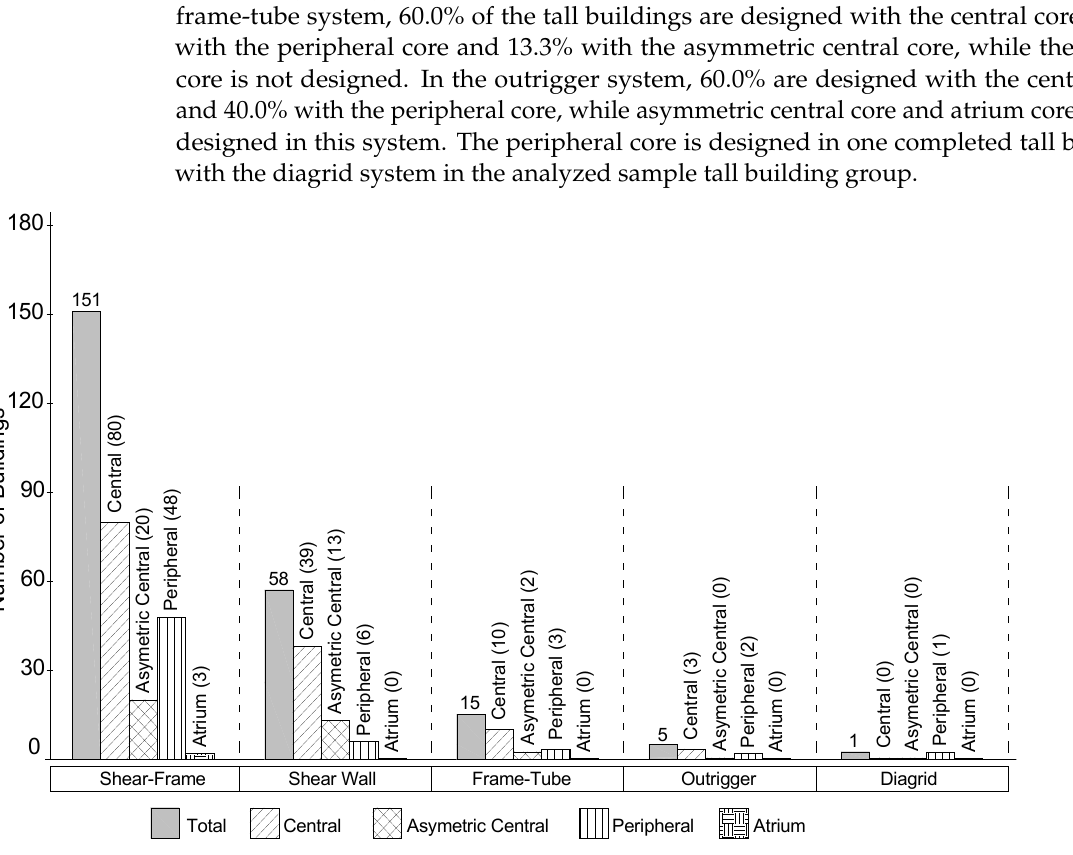
Figure 17. Relation between building structural system and building core